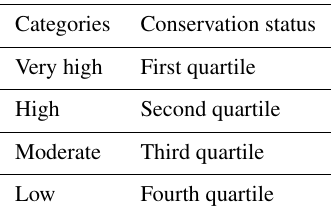
Table 3. Values assigned on the basis of conservation status ob- tained from the G200 cartography.